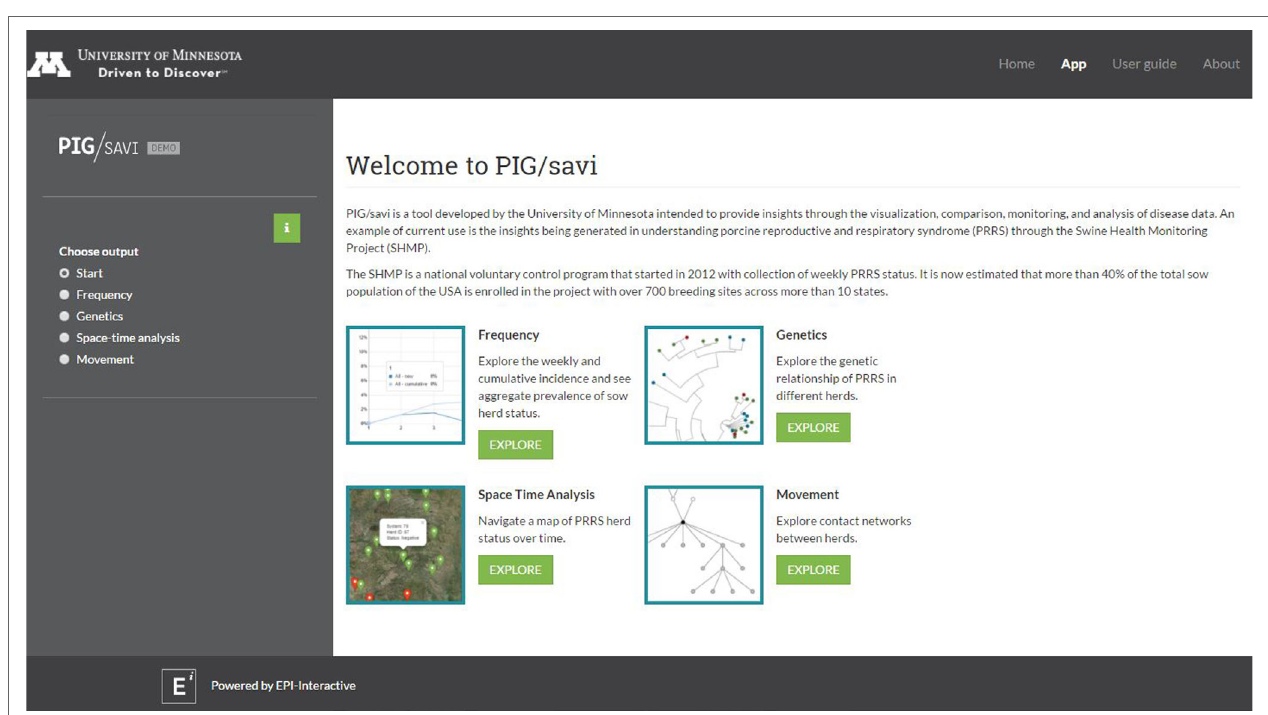
FigURe 1 | Dashboard of the RStudio Shiny-based application [Pig/Statistical Analysis and Visual Insights (SAVI)] with its four core analytical components: frequency, genetics, space time analysis, and